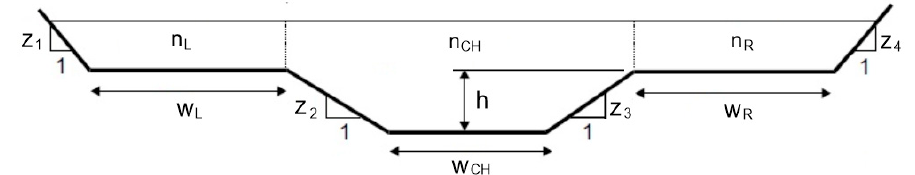
Figure 9 . Non-symmetric two stage trapezoidal compound section.